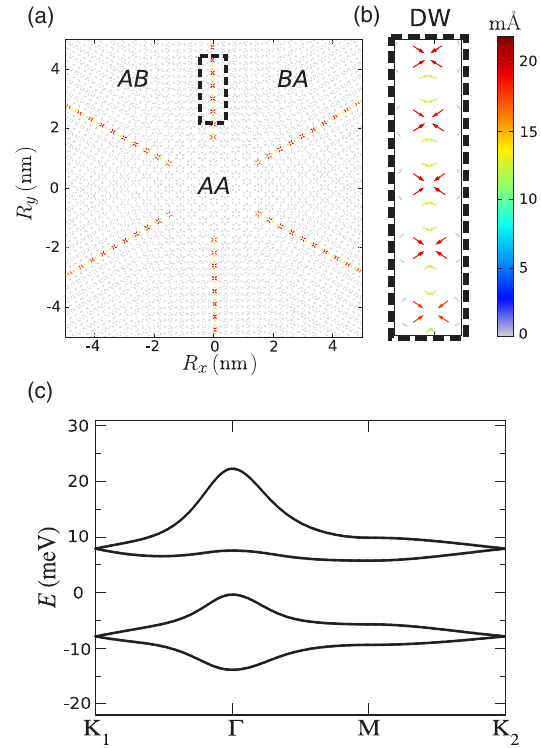
FIG. 3. (a) The displacement field η ð r Þ , Eq. (10), restricted on the DWs: the direction of the atomic displacement is depicted by a small arrow, while its magnitude in mÅ is expressed in colors. (b) Displacement along the DW area highlighted by a black dashed line in (a). The overall effect of the distortion is a narrowing of the DW. (c) Low-energy band structure of TBLG at θ ¼ 1 . 08 after the distortion in (a). The twofold degeneracies protected by the valley symmetry are completely